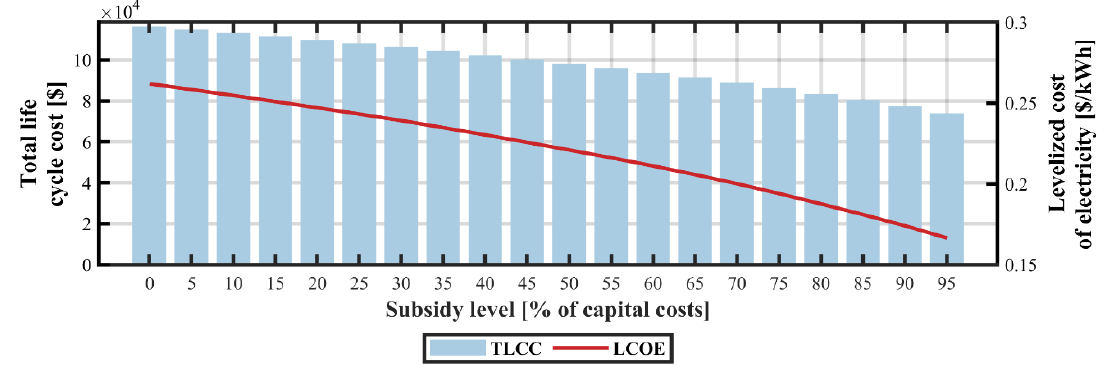
Figure 12. Simulation results of capital subsidies for PV technologies. Impact on LCOE and TLCC.